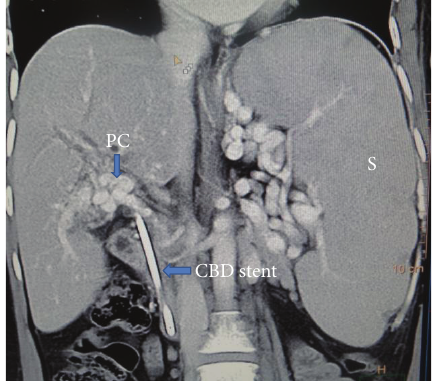
Figure 2: CT arterial portogram showing portal vein replaced by multiple collaterals, that is, cavernomatous transformation of the portalveinalsoknownasaPortalCavernoma(PC),grosslyenlarged spleen (S), and CBD stent in situ for portal biliopathy in a patient with